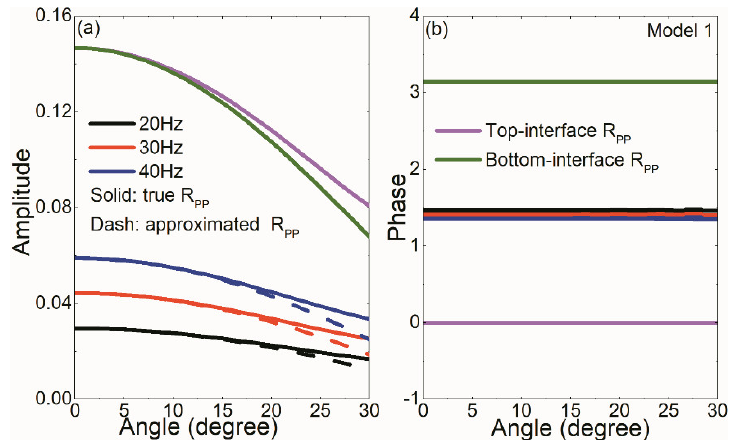
Figure 4. Comparison of Model 1’s R PP calculated by true value and the second-order series approximation, and top-interface and bottom-interface R PP calculated by the Zoeppritz equations, ( a ) amplitude, and ( b ) phase.